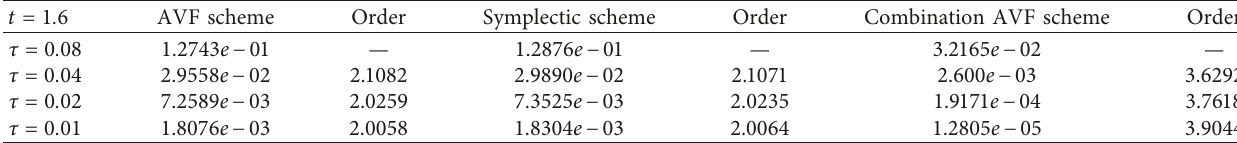
Table 1: The L ∞ errors and the order of convergence of three different schemes with h � 0 . 02 and different time steps at t � 1 . 6. t � 1 . 6